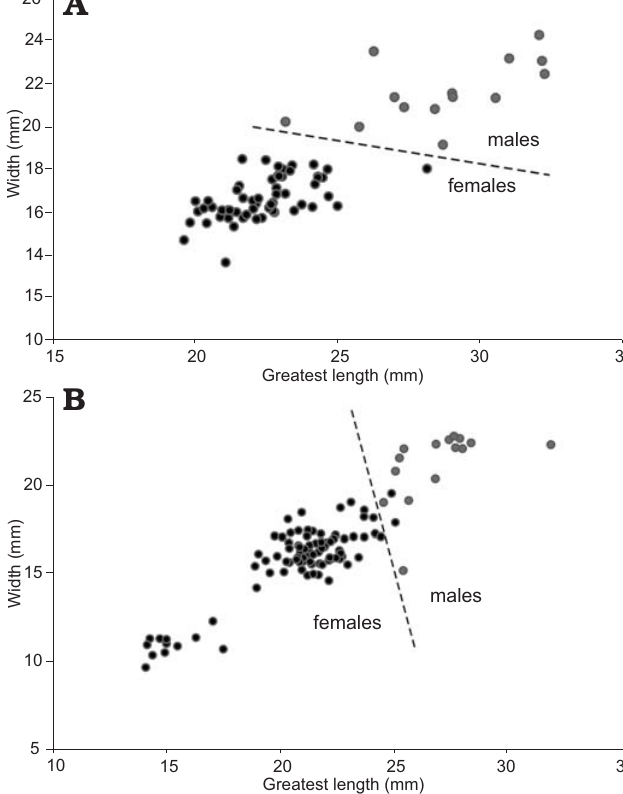
Fig. 5. Greatest length vs. width for the lower ( A , N = 74) and upper ( B , N = 105) cave bear canines from Ur ş ilor (~45–40 calendar kyrs